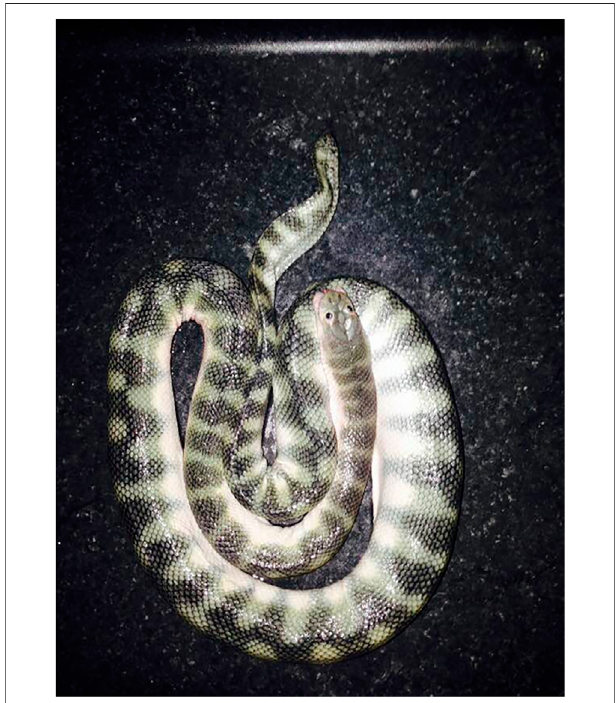
FIGURE 2 | Photograph of a Hydrophis zweifeli (Beaked sea snake — formerly known as Australian Enhydrina schistosa ) (credit: Jamie Seymour).